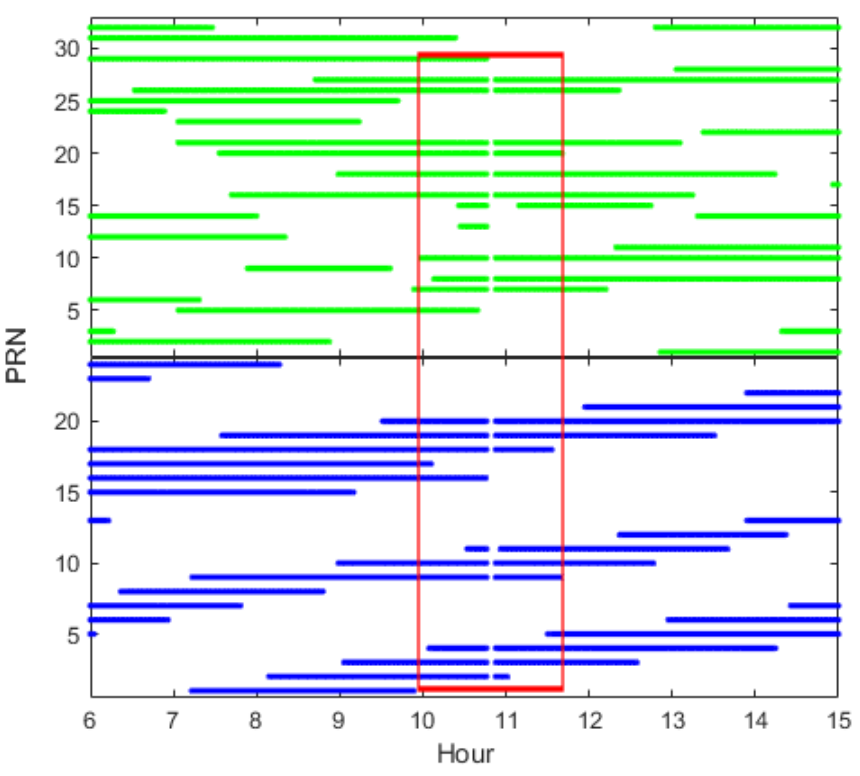
Figure 10. Satellite visibility of GPS ( top ) and GLONASS ( bottom ) at PT11 on DOY 235, 2017.